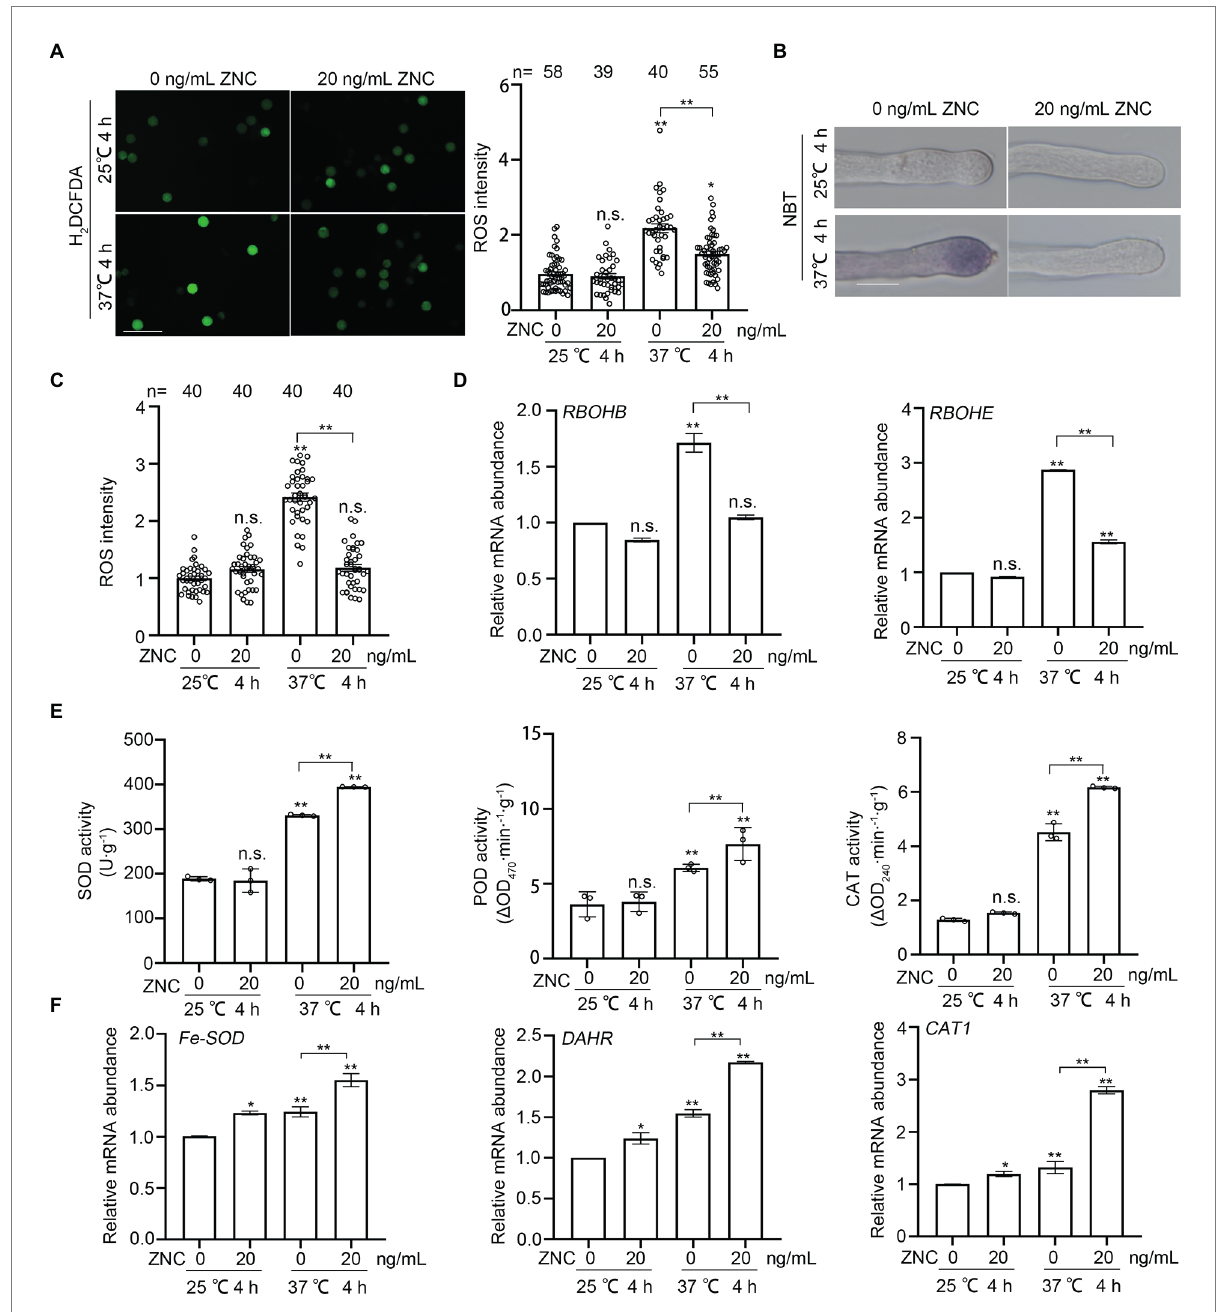
FIGURE 3 ZNC reduces short-term heat-induced ROS accumulation in pollen grains and pollen tubes. (A) H 2 DCFDA staining show ROS accumulation in pollen grains. Scale bar, 100 μ m. ROS intensity was measured by ImageJ and ROS in pollen grains at 25 ° C without ZNC treatment were set at 1 for comparative analyses. n denotes the number of pollen grains. (B,C) NBT staining show ROS accumulation in pollen tubes. Scale bar, 10 μ m. ROS intensity was measured by ImageJ and ROS in pollen tubes at 25 ° C without ZNC treatment were set at 1 for comparative analyses. n denotes the number of pollen tubes. (D) Expressions of RBOH genes, RBOHB and RBOHE , after 4 h at 37 ° C with ZNC treatment. (E) Expressions of anti-oxidant related genes, Fe-SOD , DAHR and CAT1 , after 4 h at 37 ° C with ZNC treatment. (F) Enzyme activities of SOD, POD and CAT after 4 h at 37 ° C with ZNC treatment. Bars represent means ± SE m. Asterisk on the top of data bar indicates significant difference (two-tailed t -test, * p < 0.05, ** p < 0.01) compared with the data bar on the far left, while asterisk above the bracket represents comparison between the two data bars indicated. The symbol n.s. indicates no difference. All experiments have 3 biological replicates and they have similar